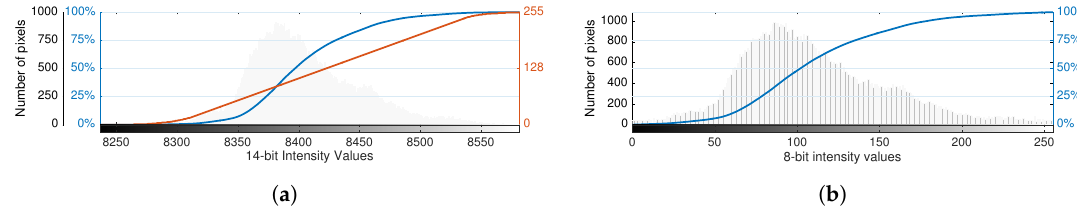
Figure 4. Automatic gain control with the plateau equalization algorithm: ( a ) the raw data histogram, with the respective cumulative distribution function (in blue), is clipped according to a prescribed plateau value to generate the transformation function (in red); ( b ) the data are compressed through the previous transformation, resulting in the histogram for 8-bit intensity values with the corresponding cumulative distribution function (in